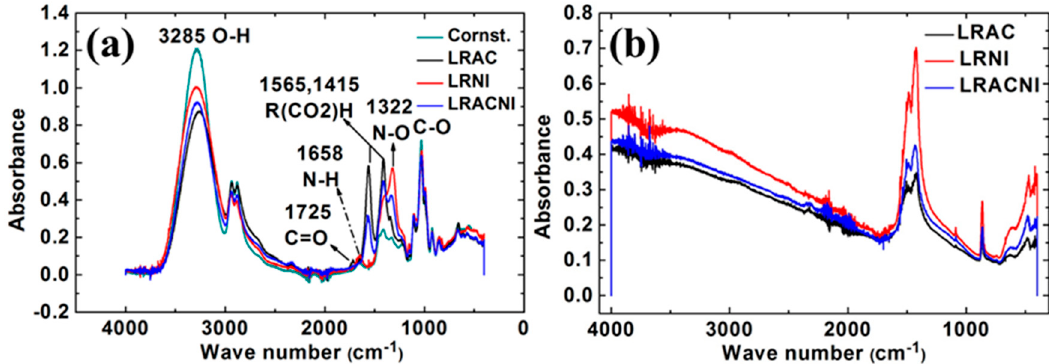
Figure 1. FTIR spectra of ( a ) gel sample, and ( b ) dry powder. The acetyl in the LRAC demonstrates the reaction of cornstarch with acetates, disrupting gel formation.